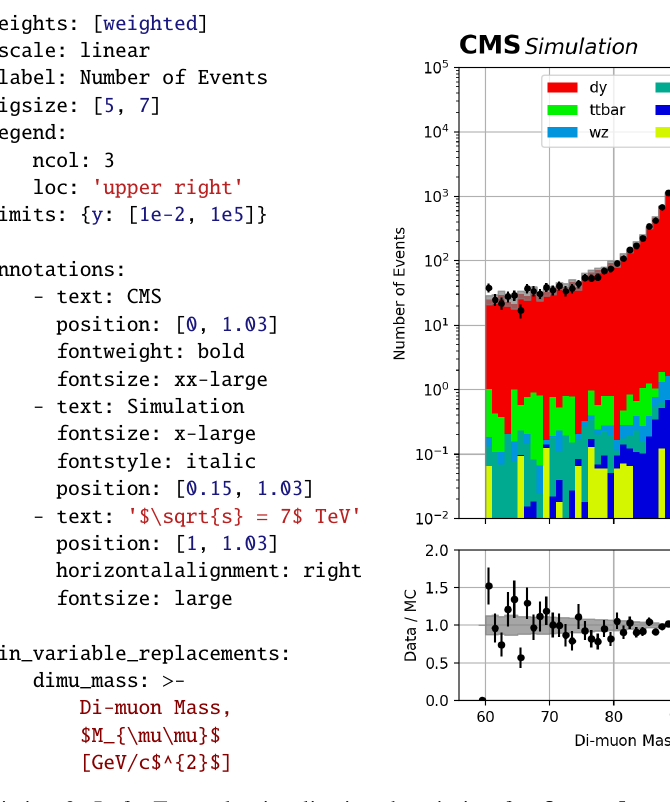
Listing 3: Left: Example visualisation description for fast-plotter ; Right: the result of using this description on the binned dataframe for the DiMuonMass stage from